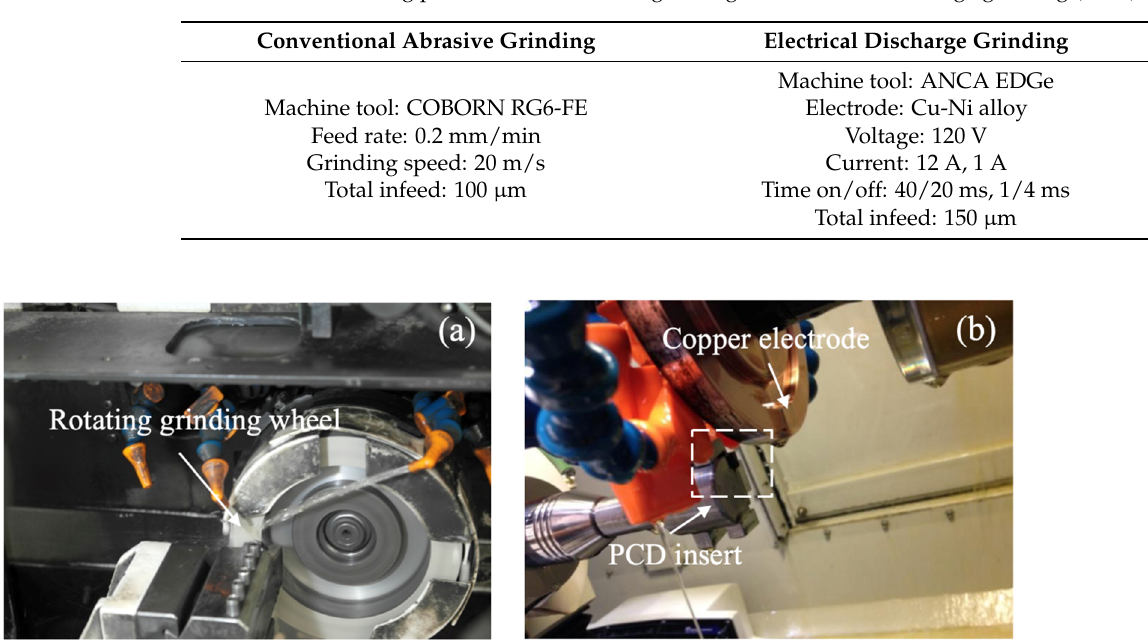
Table 2. The machining parameters of abrasive grinding and electrical discharge grinding (EDG).